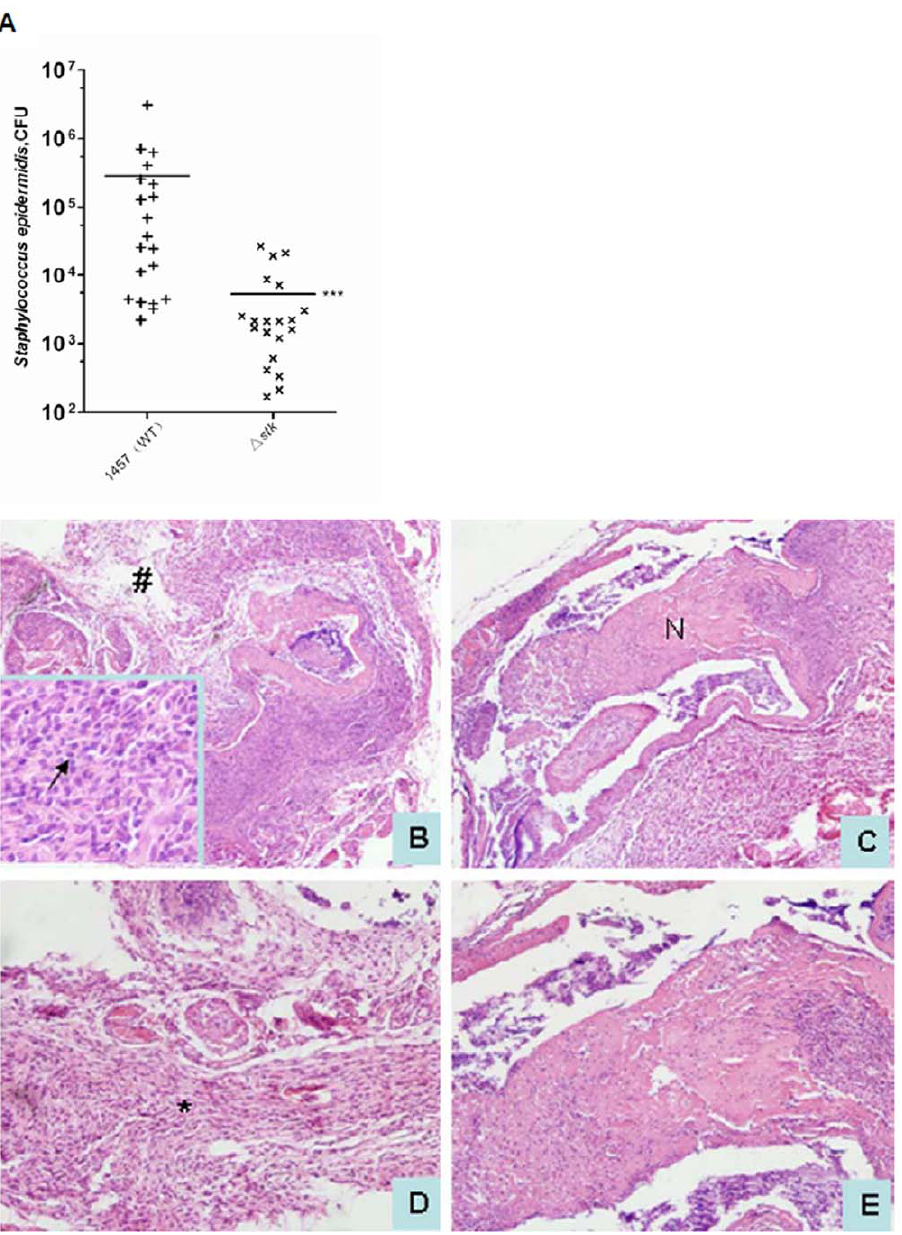
Figure 6. Murine model of subcutaneous catheter infection. A. Catheters were inserted into the subcutaneous tissue of mice, followed by the injection of 1 6 10 7 CFU of the S. epidermidis 1457 WT or stk mutant strain. After 10 days, catheters were removed from all mice and CFUs of recovered bacteria on the catheters were counted. Data were analyzed using a Mann-Whitney test. The horizontal line represents the median. ***, P , 0.001. B– E. Histopathological analysis of skin tissues around catheters infected with either S. epidermidis 1457 wild-type ( B, D ) or its isogenic stk mutant ( C, E ). B, C : Low magnification (100 6 ); D, E : High magnification (200 6 ). * denotes disseminated inflammatory cells, # denotes disrupted structure, N denotes normal structure. The black arrow in the panel B insert (400 6 magnification) indicates infiltrating